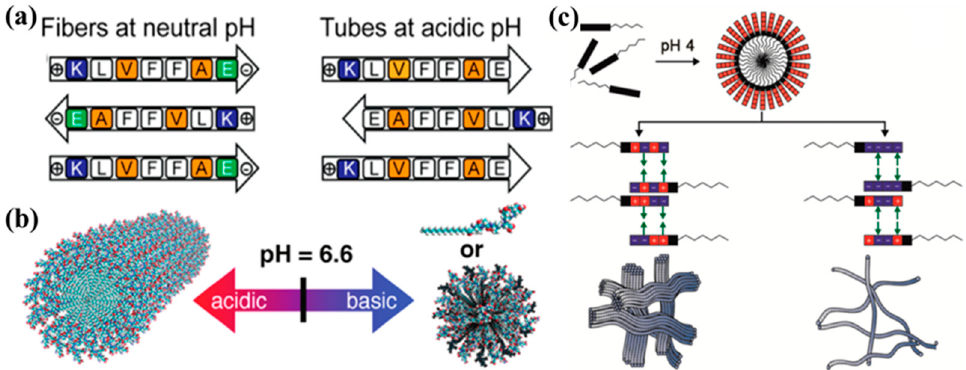
Figure 7. The pH effect on the self-assembly of biomolecules: ( a ) Self-assembled fibers and tubes under different pH conditions. Reprinted with permission from [112]. Copyright 2017 American Chemical Society. ( b ) The pH-triggered morphological transition of self-assembling PA. Reprinted with permission from [113]. Copyright 2012 American Chemical Society. ( c ) Self-assembled nanofibers by pH-mediated lateral assembly. Reprinted with permission from [114]. Copyright 2015 American Chemical